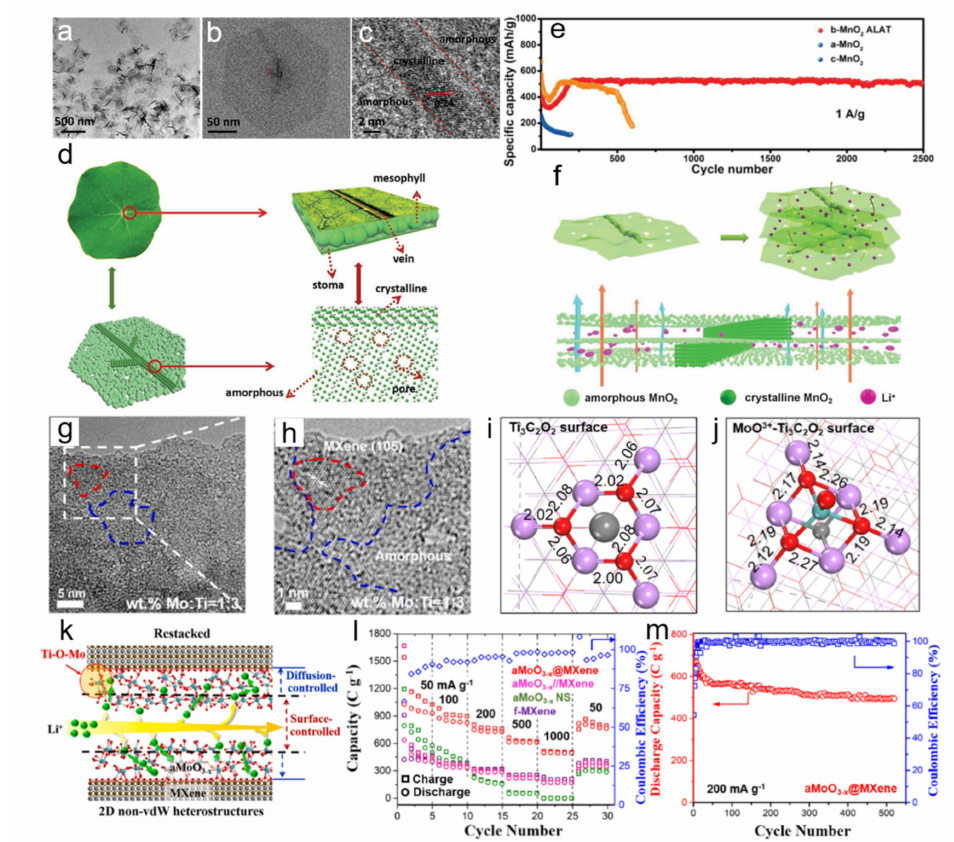
Figure 3. ( a , b ) TEM images of b-MnO 2 ALAT; ( c ) HRTEM image of b-MnO 2 ALAT; ( d ) Illustration of the breathable artificial leaves structure; ( e ) Cycling performance of b-MnO 2 ALAT at 1 A g − 1 ; ( f ) Schematic illustration of advantageous features of b-MnO 2 ALAT for energy storage. Reprinted with permission from Ref. [48]. Copyright Wiley-VCH, 2019. ( g , h ) HRTEM images of 2D heterostruc- tures of aMoO 3-x @MXene non-vdW heterostructures; ( i , j ) Ti-O bond lengths in MXenes before and after the adsorption of MoO 3+ , respectively; ( k ) Illustration of facile capacitor-like interlayer diffusion and diffusion-controlled interlayer diffusion; ( l ) Cycling performance at different rates for aMoO 3-x NS, self-assembled aMoO 3-x //MXene vdW heterostructures, and aMoO 3-x @MXene non-vdW heterostructures; ( m ) Cycling performance for aMoO 3-x @MXene non-vdW heterostructures at 200 mA g − 1 . Reprinted with permission from Ref. [49]. Copyright Elsevier,